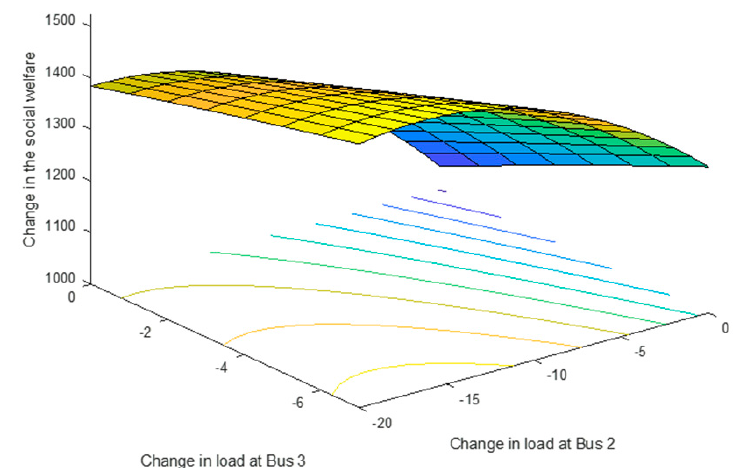
Figure 9. Equi-cost contour of social welfare as a function of two variable loads in the IEEE 3-bus system.